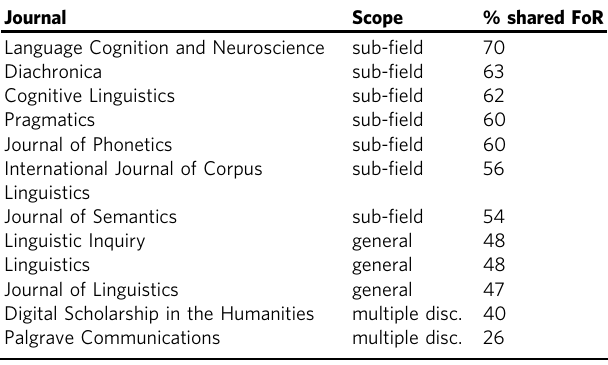
Table 1 Linguistics journals by scope and percentage of shared FoR codes between 2019 articles and their references, based on Dimensions data.